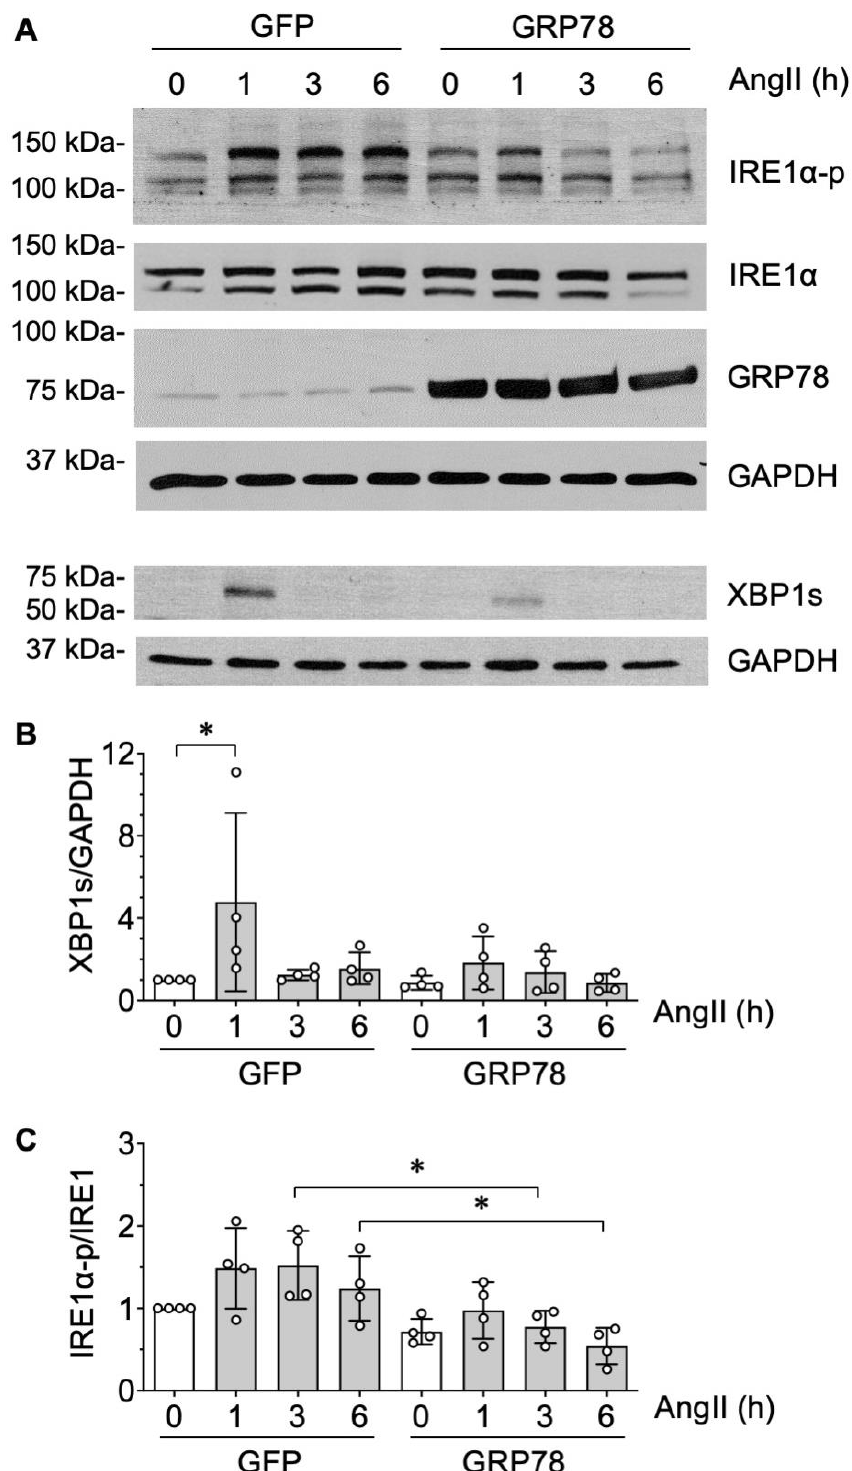
Figure 3. The inositol-requiring enzyme 1 α (IRE1 α ) / X-box-binding-protein 1 spliced isoform (XBP1s) arm of unfolded protein response (UPR) is induced by angiotensin II in VSMCs. ( A , B and C ) The rat aortic VSMCs infected with adenovirus encoding GRP78 or control GFP (100 moi) for 48 h were stimulated with 100 nM AngII (AII) for 1–6 h and immunoblotting was performed as indicated. ( A ) Representative blots from 4 independent experiments. ( B ) Signal intensity was used to calculate the expression ratio of XBP1s to GAPDH. ( C ) Signal intensity was used to calculate the IRE1 α Ser724 phosphorylation ratio to the total IRE1 α . The bars in the graphs show the mean ± SD from 4 independent experiments. * indicates p <